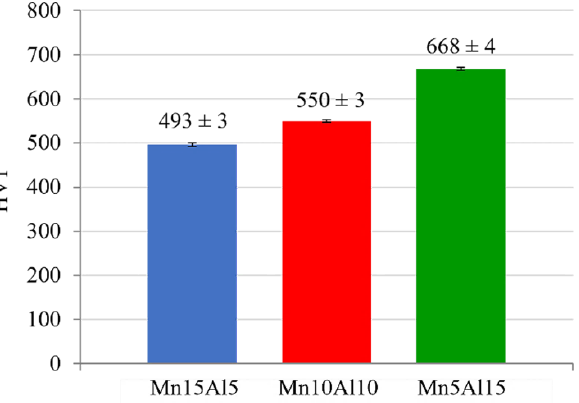
Figure 9. Vickers hardness of the MA + SPS compact alloys. (Error bars represent confidence inter- vals).